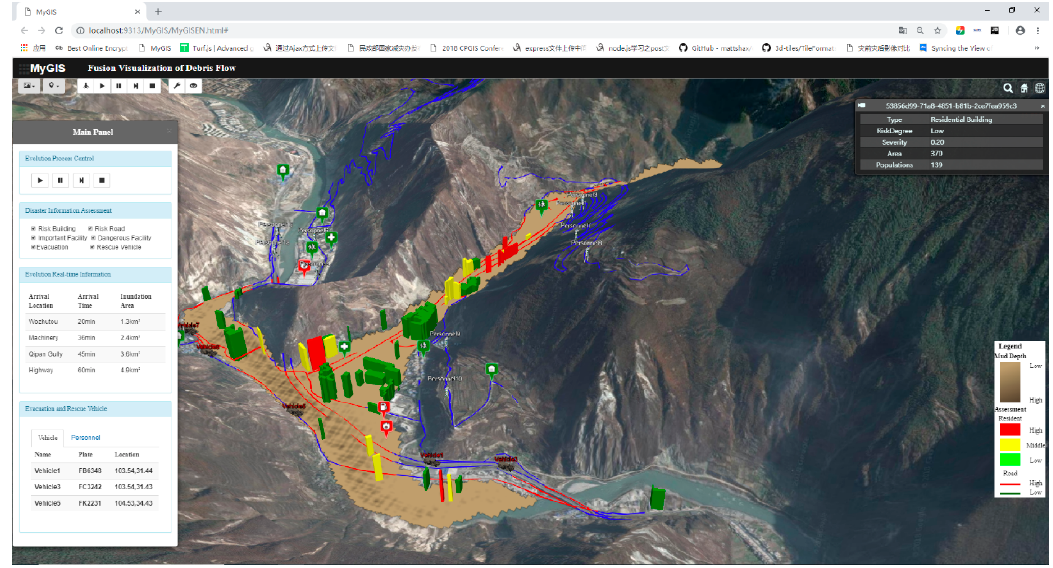
Figure 11. Fusion visualization of debris flow disaster scenes with spatial semantic constraints.